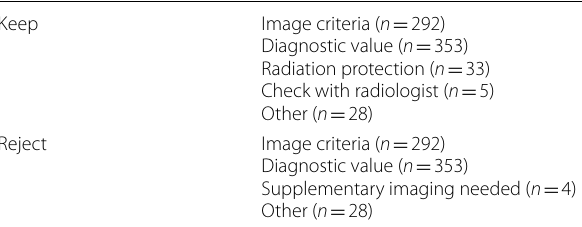
Table 3 Overview of categories of comments on kept and rejected